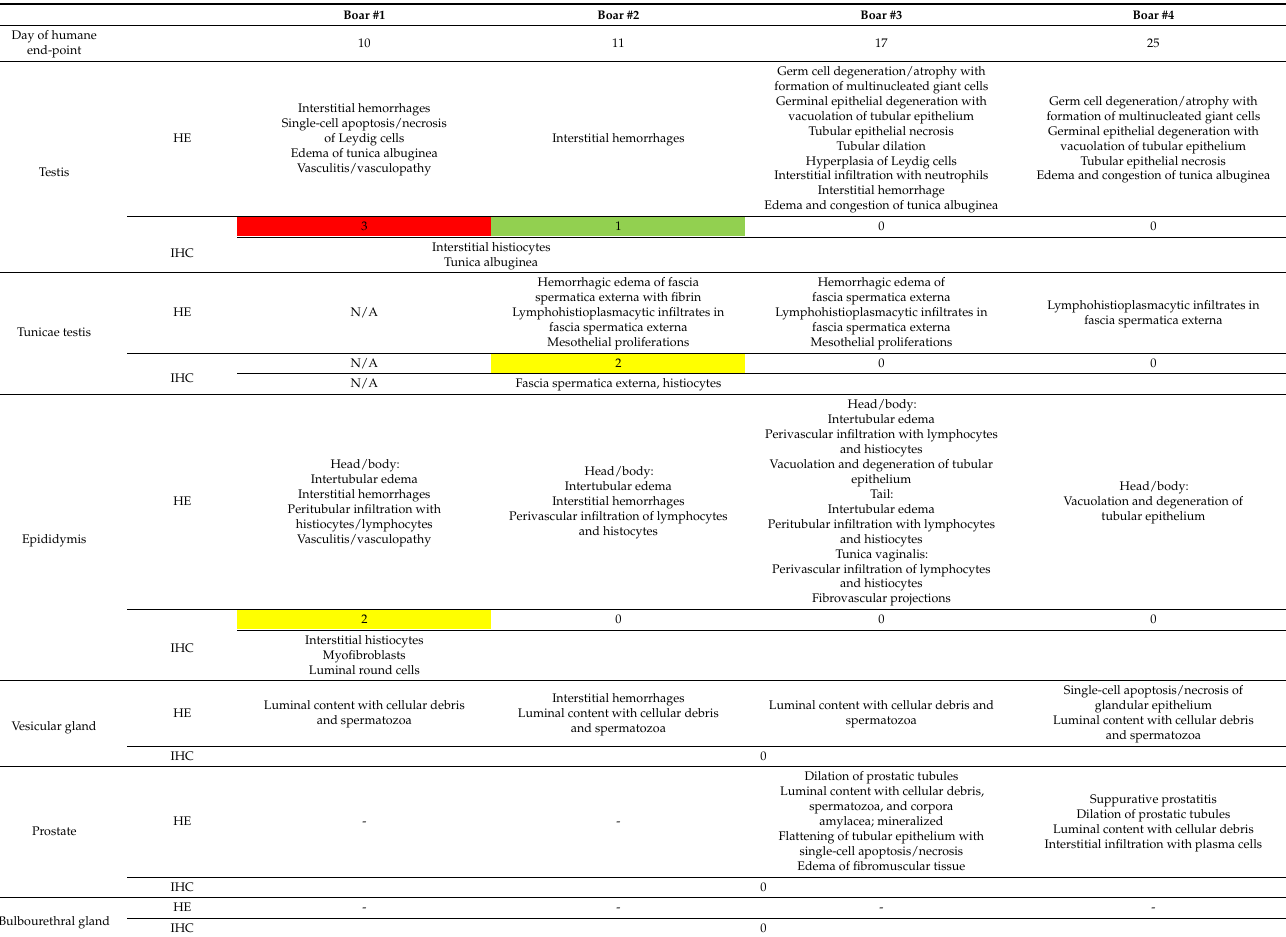
Table 2. Histopathological findings of reproductive organs detected in ASFV-infected mature domes- tic breeding